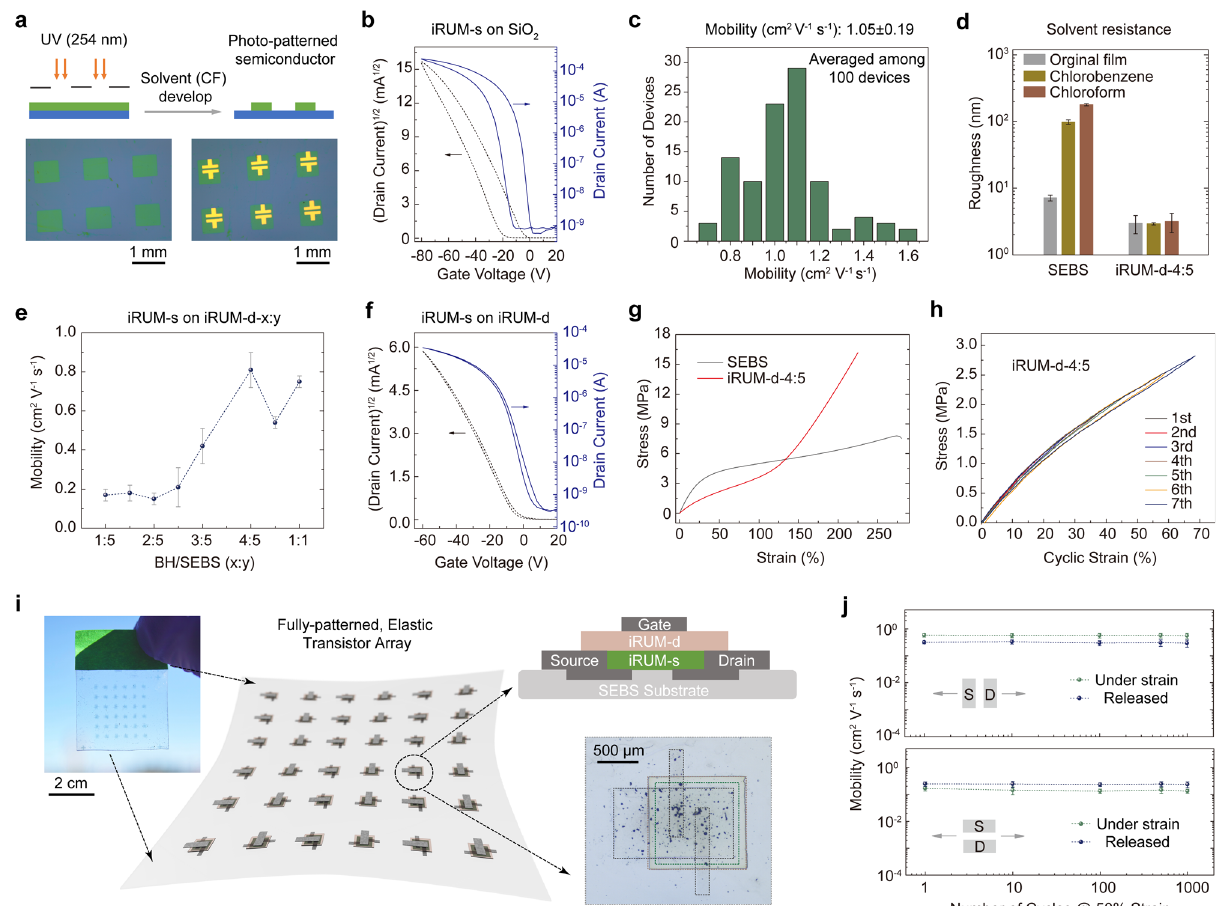
Fig. 4 The photo-patternability of iRUM-s and iRUM-d, and the integrated patterned elastic transistors on a single substrate. a Schematic illustration of the photo-patterning process for iRUM-s, which involves selective UV exposure and chloroform development. Optical microscope images of photo- patterned iRUM-s fi lm (thickness: 35 nm) before and after depositing MoO 3 /Au (2 nm/55 nm) electrodes. b A representative transfer curve of iRUM-s fi lm that is photo-patterned on OTS-modi fi ed SiO 2 (300 nm) as characterized in a bottom-gate top-contact transistor. c Mobility distribution of photo- patterned iRUM-s from 10×10 photo-patterned transistors on a single substrate, with bottom-gate top-contact con fi guration, highly doped Si as gate electrode, MoO 3 /Au as source/drain electrodes ( W = 500 µ m, L = 50 µ m) and octadecyltrimethoxysilane (OTS)-modi fi ed SiO 2 (300 nm) as dielectrics. d Surface roughness characterization of SEBS and iRUM-d-4:5 fi lms by pro fi lometer before- and after-solvent treatment. e The mobility of photo-patterned iRUM-s fi lm on iRUM-d-x:y (1 – 1.5 μ m thick), where x:y is the BH-to-SEBS weight ratio. f A representative transfer curve of a bottom-gate top-contact transistor with iRUM-s directly photo-patterned on iRUM-d-4:5 (1 μ m thick). g The representative stress-strain curves for SEBS and iRUM-d-4:5 fi lms obtained from pseudo-free-standing tensile tests. h Cyclic stress-strain curves (10 – 70% strains) for iRUM-d-4:5. i Schematic of fully patterned, stretchable, and elastic transistors on a single substrate. Two-dimensional diagram showing the side view of the transistor structure. j Changes in mobility for the patterned elastic transistors after multiple stretching-releasing cycles at 50% strain, with charge transport parallel and perpendicular to stretching